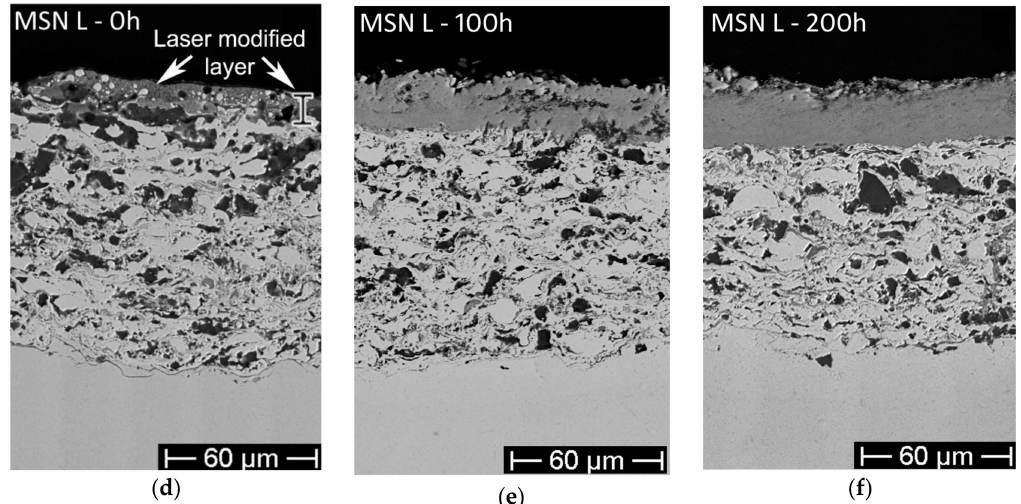
Figure 5. Cross-sections of the MSN samples: ( a ) As-sprayed; ( b ) as-sprayed after 100 h of hot corrosion test; ( c ) as-sprayed after 200 h of hot corrosion test; ( d ) laser-treated; ( e ) laser-treated after 100 h of hot corrosion test; and ( f ) laser-treated after 200 h of hot corrosion test.